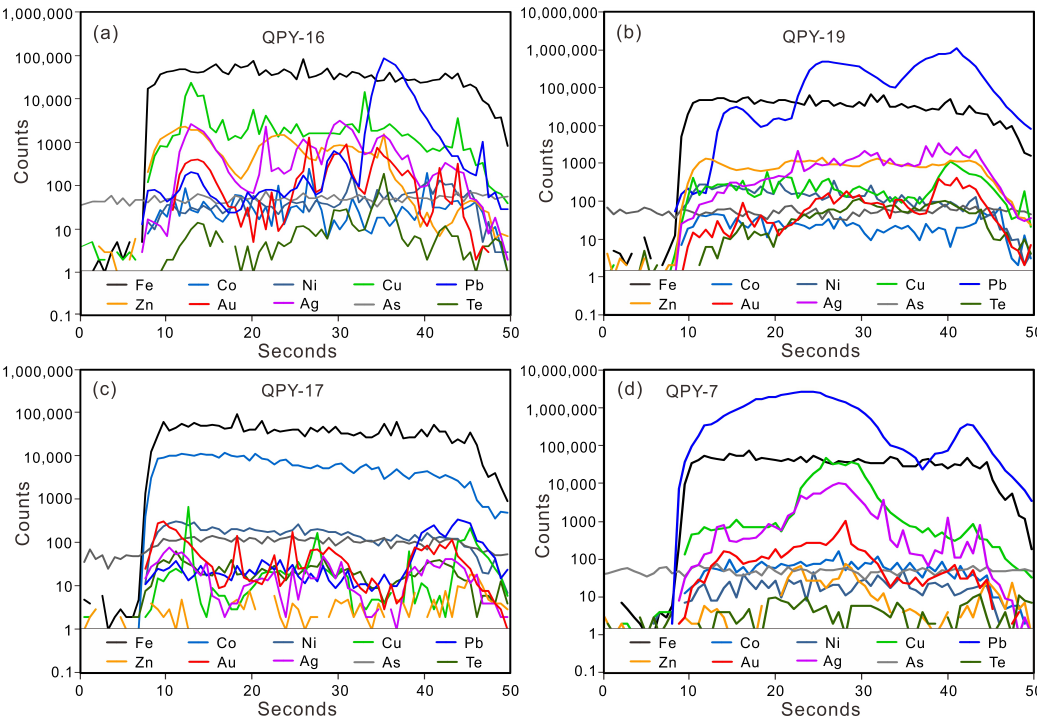
Figure 6. LA-ICP-MS time-resolved depth profiles for Au in Py2 display several spikes ( a , b ), indicating the occurrence of Au in Py2 as nano- to submicron-sized inclusions. Spikes of Cu, Pb, Zn, and Ag in the profiles are similar to those of Au in most samples ( c , d ), suggesting that gold occurs as complex Au-Cu-Pb-Zn-Ag nano- to submicron-sized inclusions in Py2.